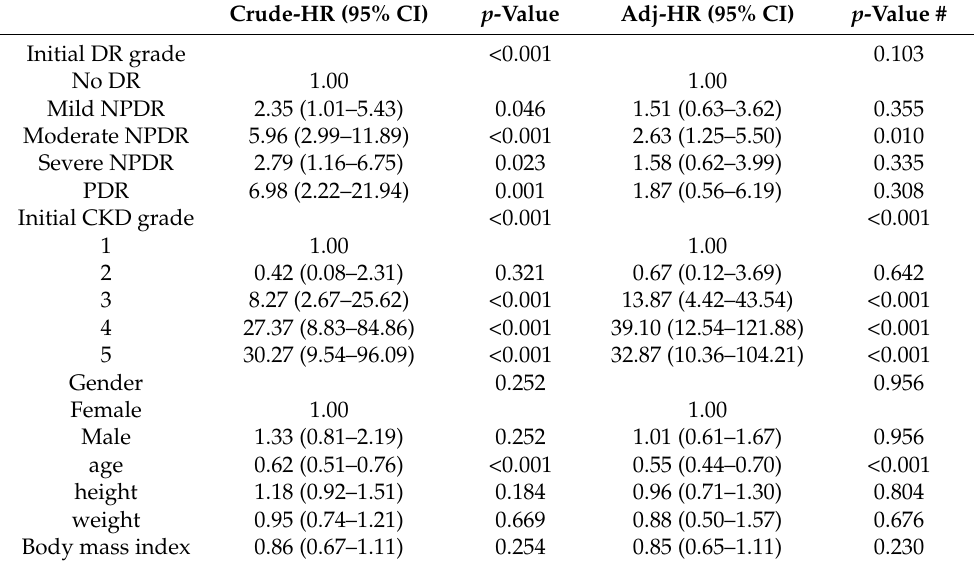
Table 3. The risk of progression to ESRD before the end of the